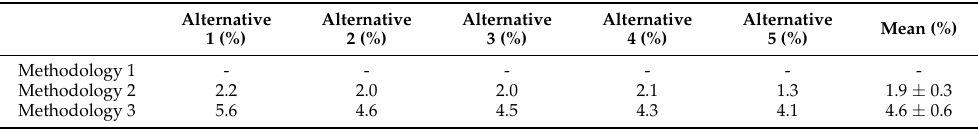
Alternative 5 (%) Mean